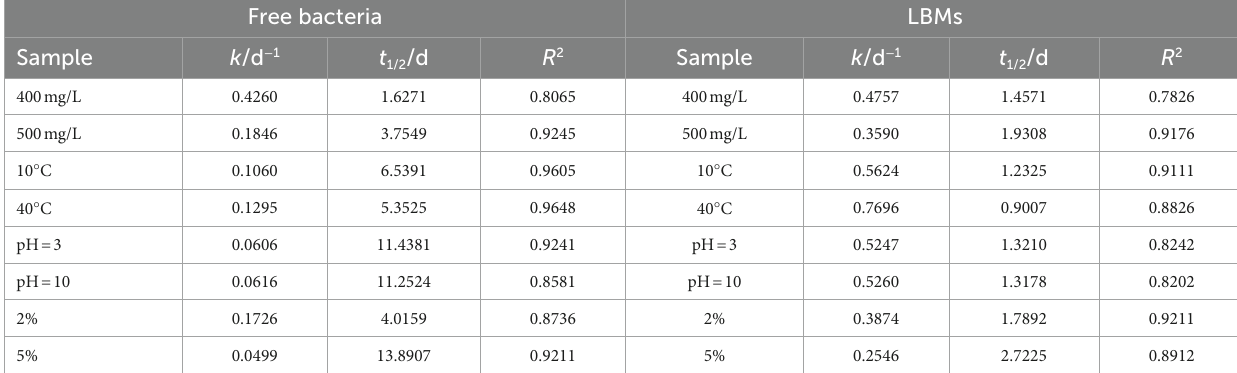
TABLE 2 Kinetic parameters of toluene removal by free bacteria and